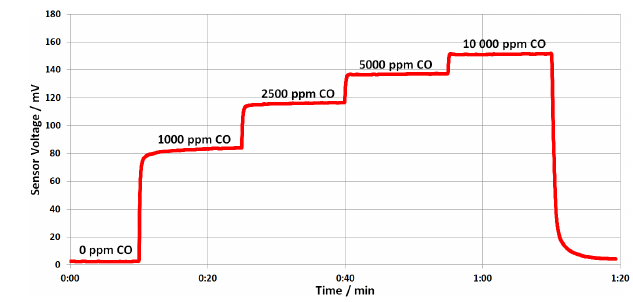
Figure 3. Sensor response of the COe MXP sensor.